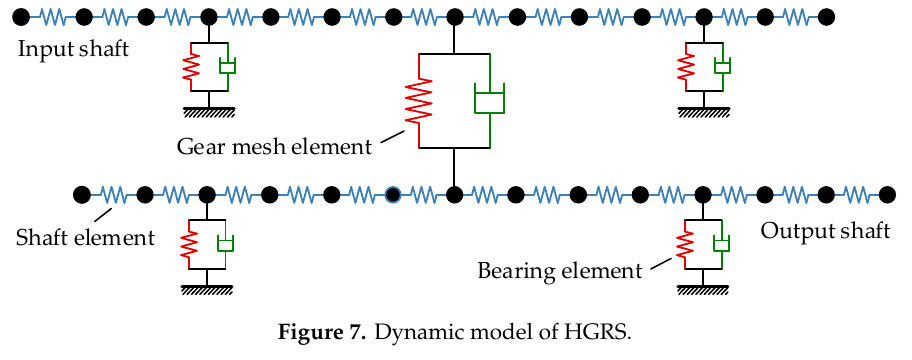
Figure 7. Dynamic model of HGRS.